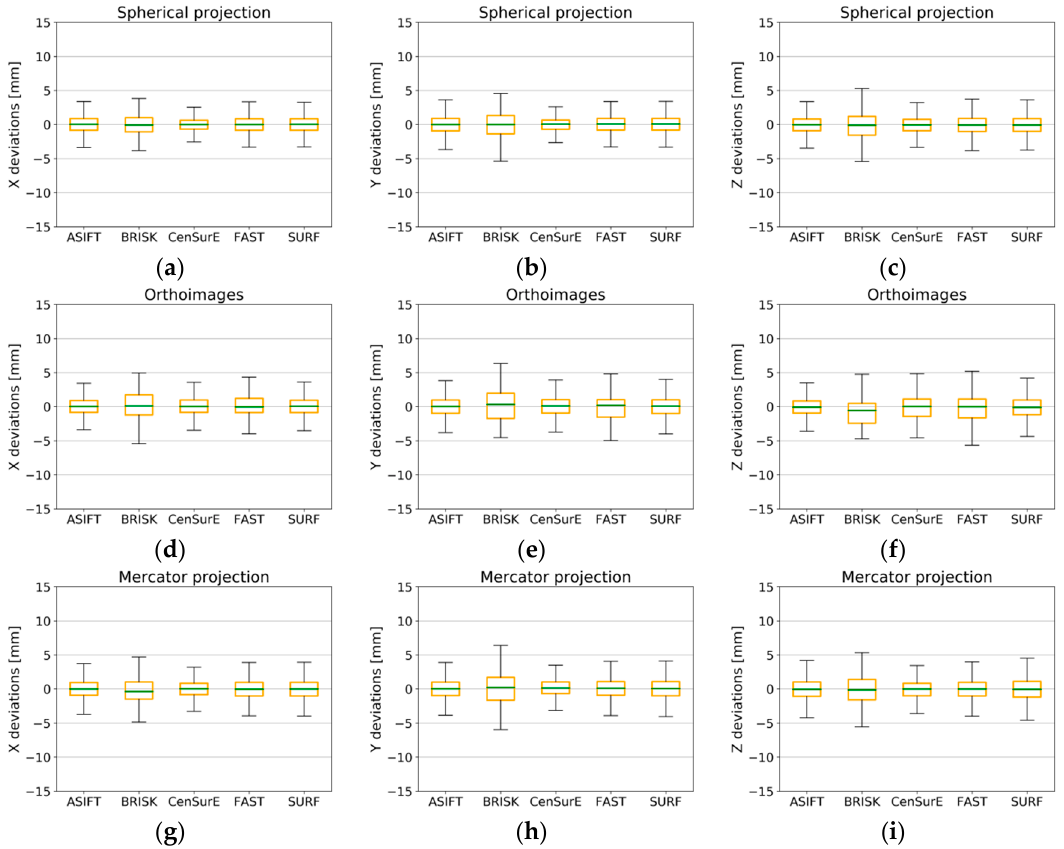
Figure 20. Box plots for the distribution of the deviations of natural check points for all pairs of fully registered scans (without points used for the ICP and non-registration) for Test Site II. The spherical projection: component—x ( a ), y ( b ), and z ( c ); orthoimages: component—x ( d ), y ( e ), and z ( f ); the Mercator projection: component—x ( g ), y ( h ), and z ( i ).